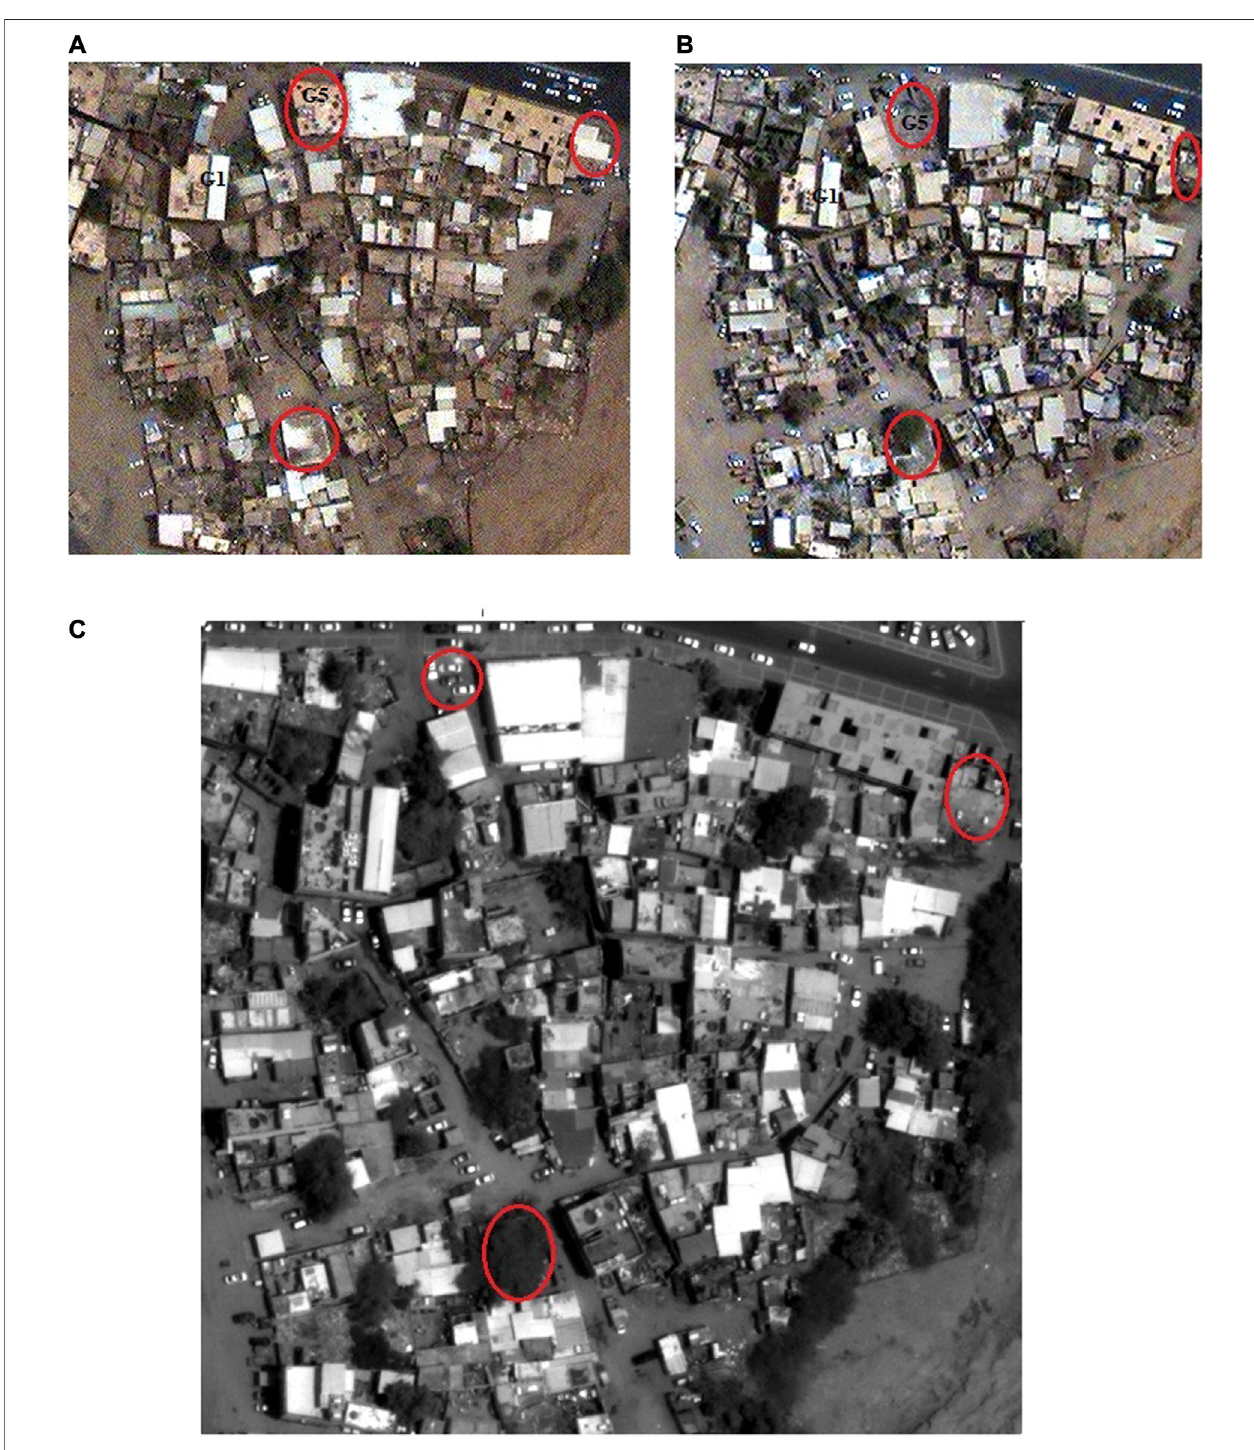
FIGURE 6 | Pan-sharpened natural color QuickBird-2 ( A (cid:1) pre-event and B (cid:1) post-event), and grayscale GeoEye-1 (C) (post-event) images of Aljabal neighborhood. Grade 1 (G1) and Grade 5 (G5) buildings are also shown on the fi gure.